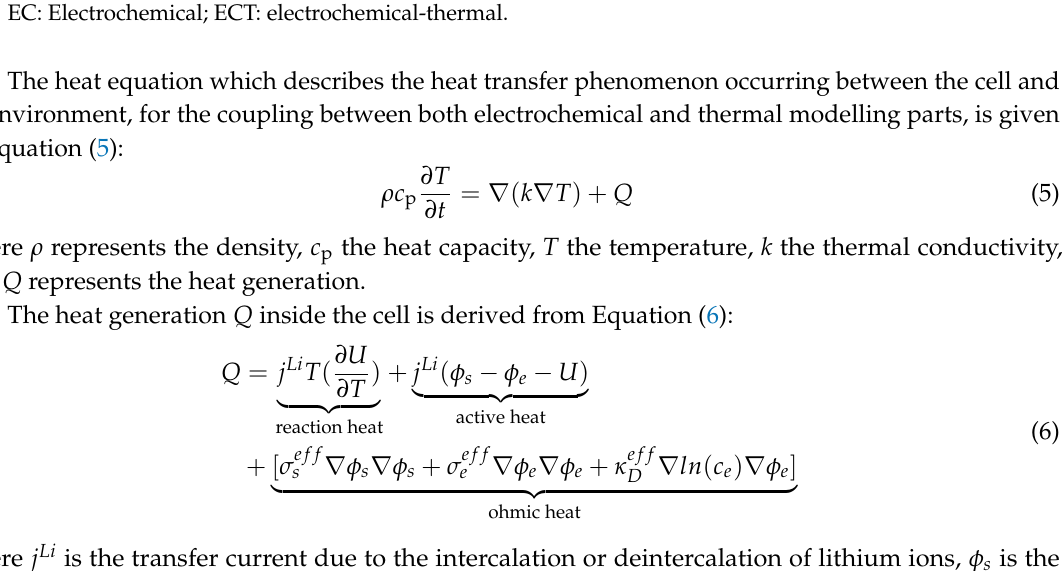
Figure 7. Representation of the coupling between the Electrochemical and the Thermal modelling parts. EC: Electrochemical; ECT: